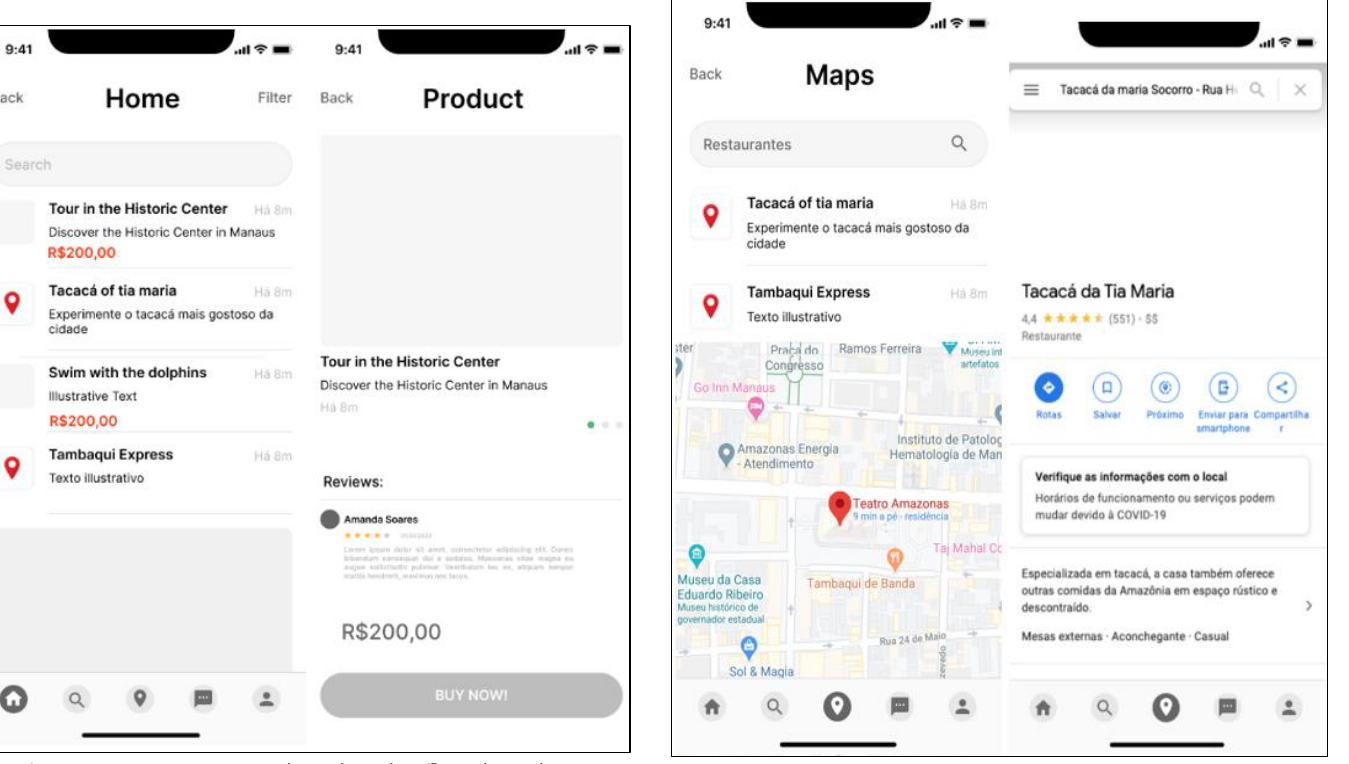
Figure 7: Map and Marketplace of tourist points. Source: Authors, (2020).